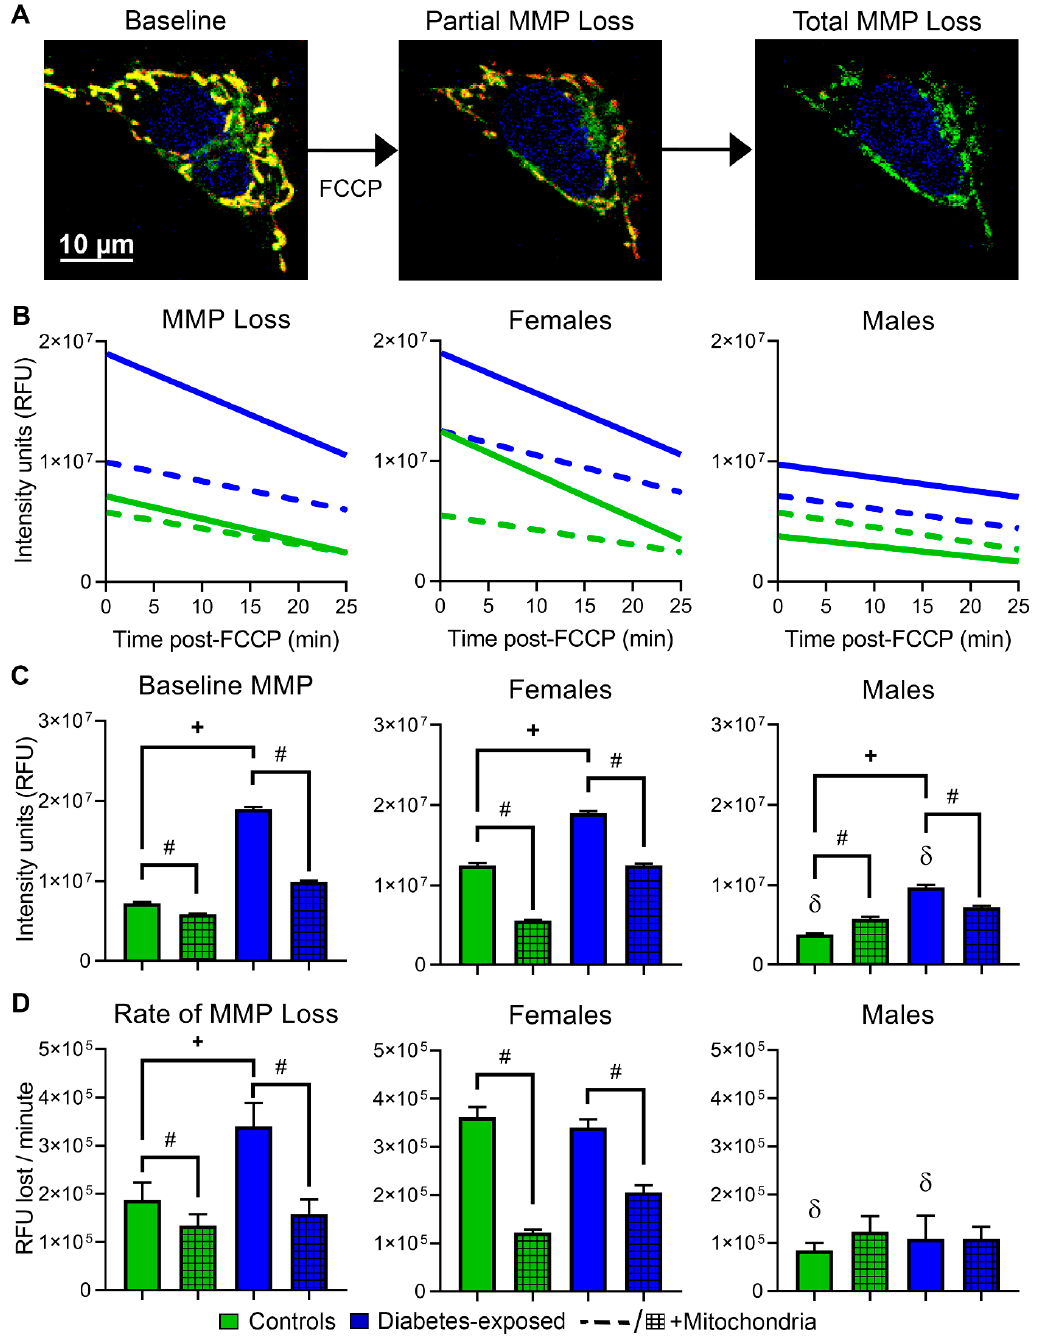
Figure 5. Females and PGDM-exposed cells have stronger mitochondrial membrane potential (MMP), but they lose it faster following metabolic stress. ( A ) Representative images of CM stained with MitoTracker Green, Hoechst, and MitoTracker Red. Once treated with FCCP, mitochondria lose their MMP and trigger cell death through intrinsic apoptosis. ( B ) MMP loss was analyzed before and following FCCP-induced stress by linear regression analysis. ( C ) Baseline MMP and ( D ) rate of MMP loss over 25 minutes of FCCP-induced stress. N = 4–5 per sex per group. Data represent mean ± SEM. P ≤ 0.05: + diabetes, # mitochondrial, or δ sex-specific effect (only lower sex marked) by 1-way ANOVA.